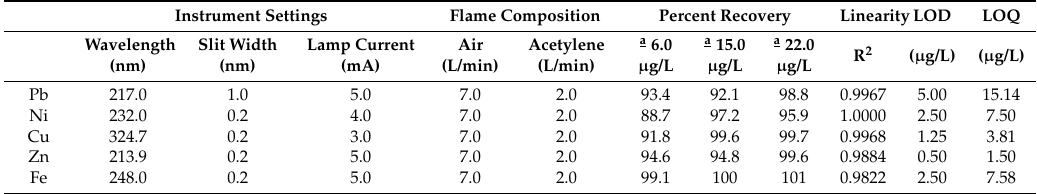
Table 1. Atomic absorption spectrometer settings and validation data for analyzed